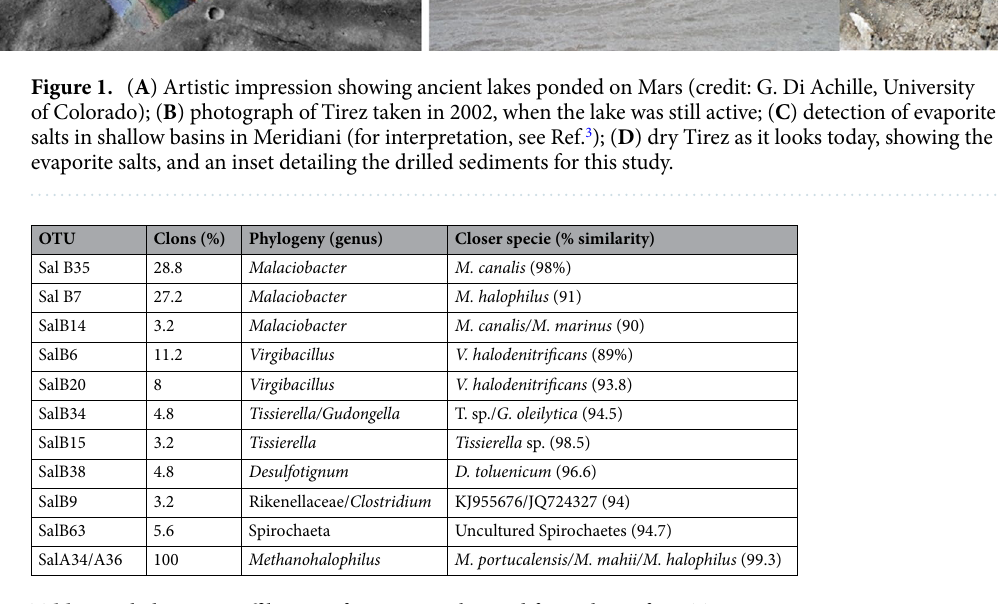
Table 2. Phylogenetic affiliation of sequences obtained from clones from Tirez Lagoon in